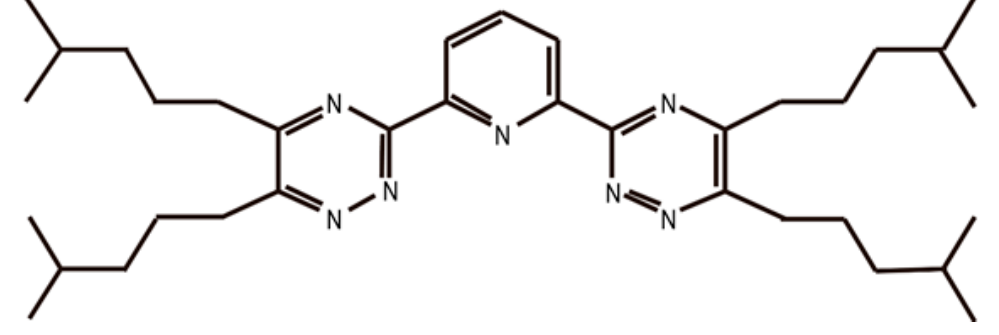
Figure 12. The chemical structure of isoHex-BTP [58]. Nanomaterials 2019 , 9 , x FOR PEER REVIEW